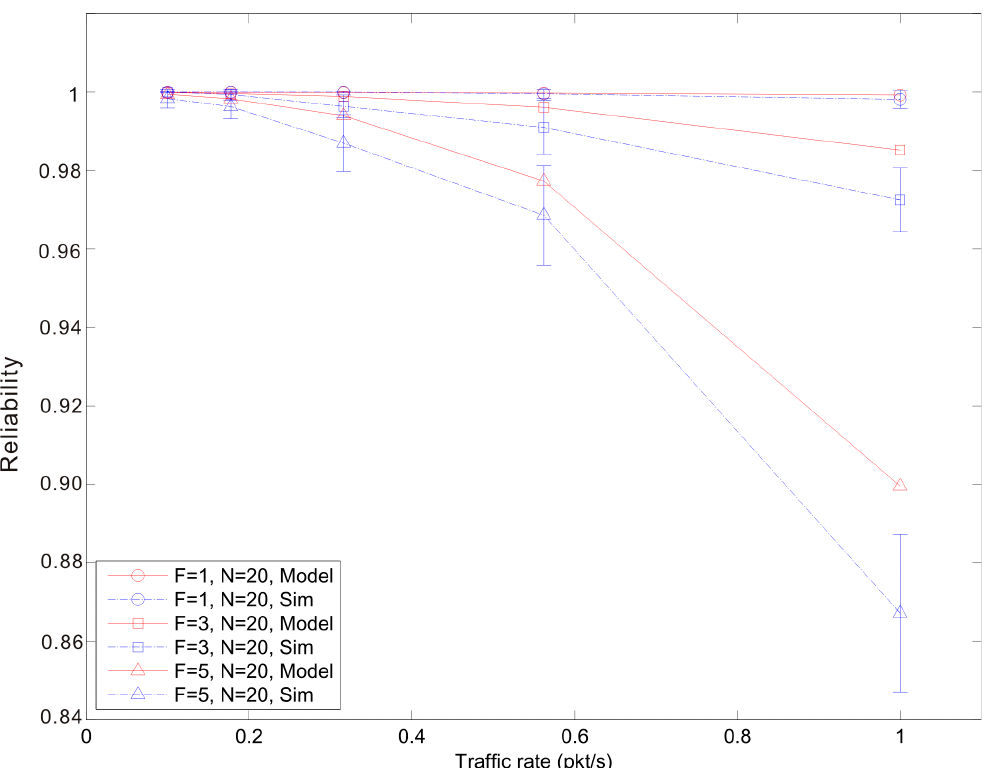
Figure 12. 6LoWPAN fragmentation reliability versus traffic rate for a star topology network composed by 20